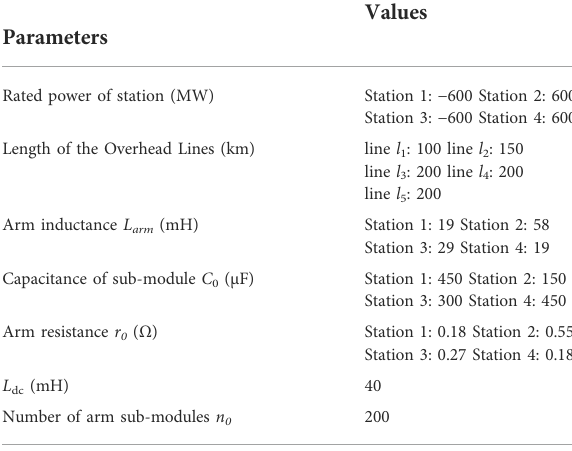
TABLE 2 Main parameters of the HVDC